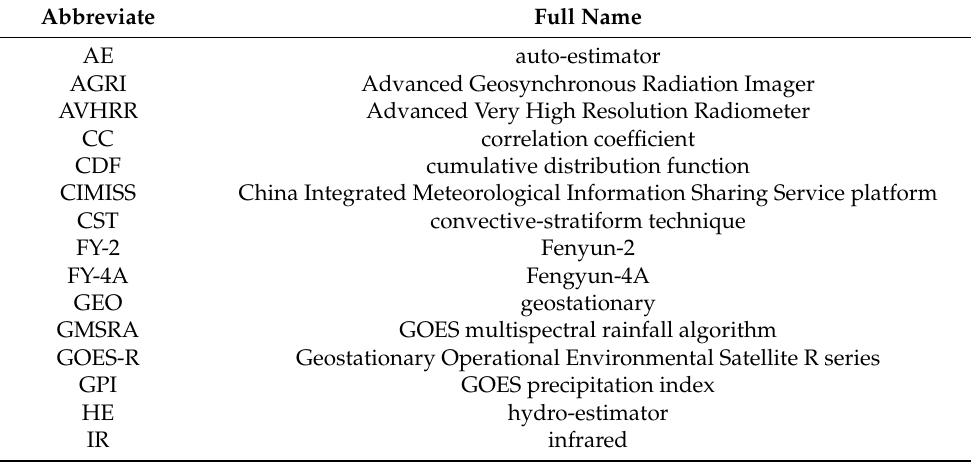
Table A1. Acronym list for the acronyms used in this study (arrange in alphabetical